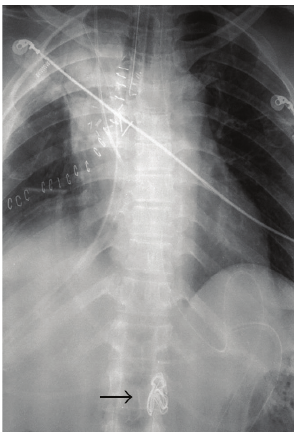
Figure 1: X-ray of chest showing location of the surgical swab (arrow).